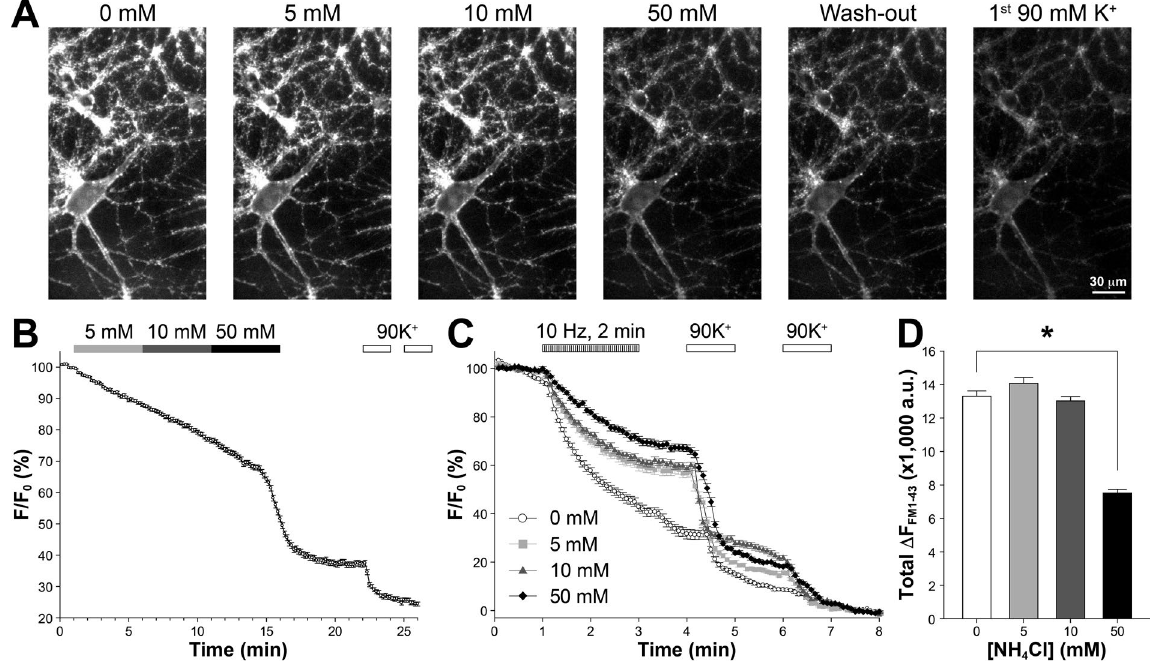
Figure 3. Effects of NH 4 Cl on synaptic vesicle (SV) release. ( A ) Sample images of neurons preloaded with FM1- 43 dye and exposed to NH 4 Cl-containing bath solutions and 90 mM K + modified Tyrode’s saline. ( B ) Averaged time-course of FM1-43 fluorescence (normalized to pretreatment baseline) during the perfusion of increasing concentrations of NH 4 Cl and 90 mM K + (randomly selected 90 ROIs/FOV and 6 FOVs). There was a